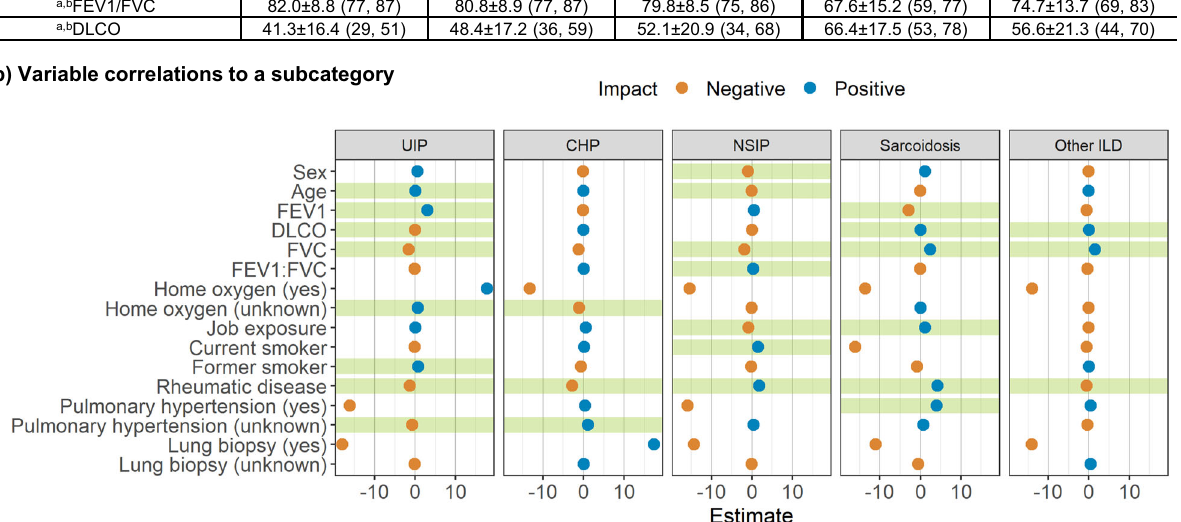
Fig. 2 | Characteristics and correlations of patient ’ s clinical history. a Characteristics of patient ’ s clinical information for each ILD subtype. a Data in parentheses show interquartile range. b Indicates mean±s.d. Data in parentheses shows the percentage of the population with the characteristic. b Correlations